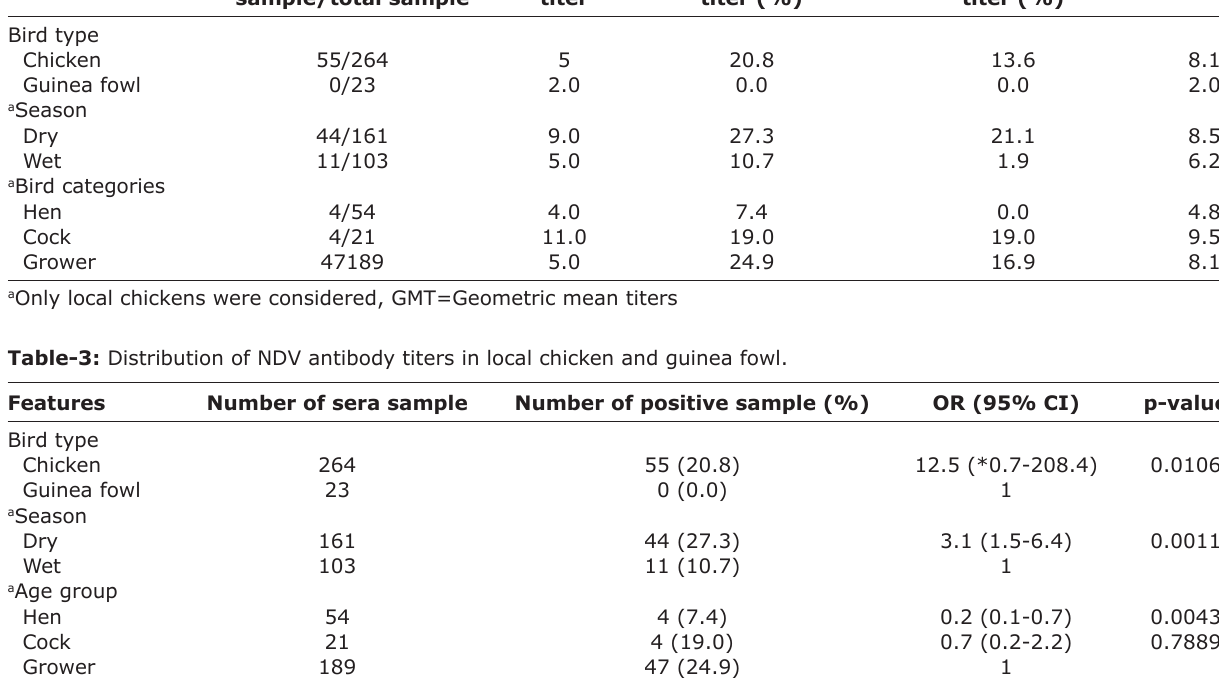
Table-2: Modal titer and percentage distribution of NDV antibody in local chicken and guinea. Features